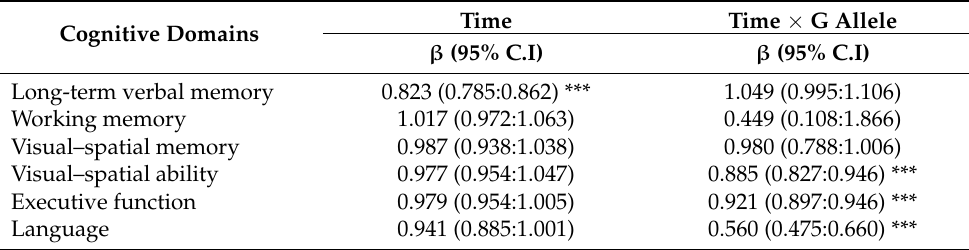
Figure 2. Longitudinal association of PER2 genotype with composite scores for executive function ( A ), language ( B ), and visual–spatial ability ( C ) in the “progressed SCD” (pSCD) group. On the x -axis, T0 indicates the baseline evaluation and T1 indicates the last neuropsychological evaluation. On the y -axis, median of composite scores ( z -score) for each cognitive domain are reported. Table 5. Generalized estimating equations for neuropsychological scores as a function of PER2 genotype over follow-up